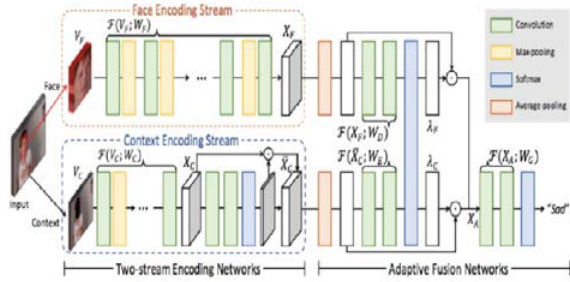
Fig. 2. Configuration of the CAER-Net consisting of dual- stream coding networks and adaptive merge